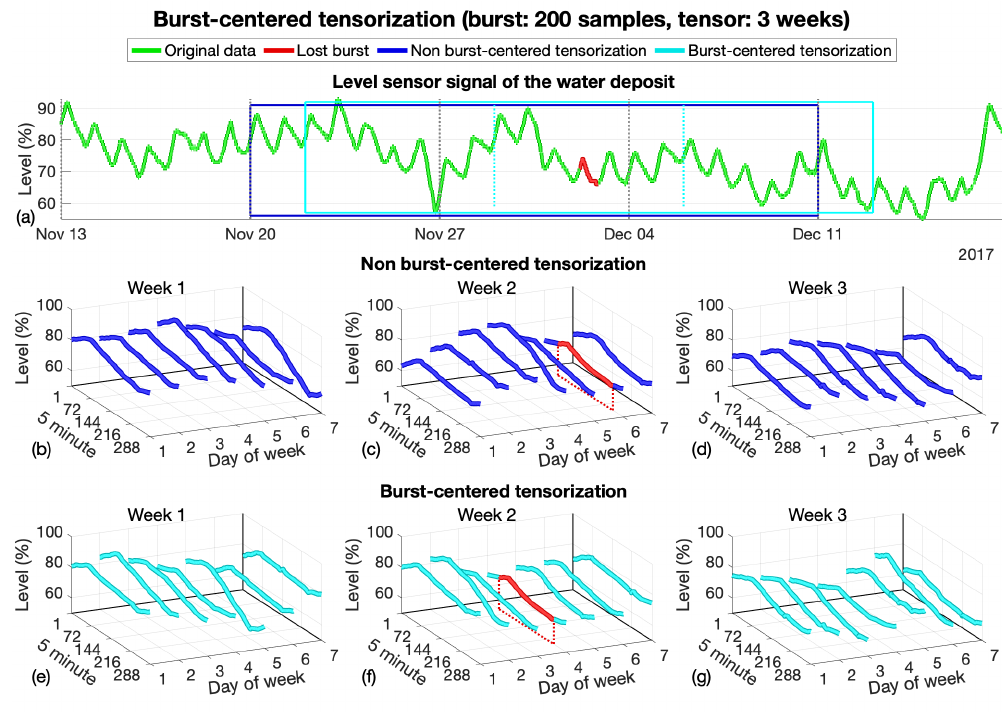
Figure 6. Example of the data tensorization of a 3 week tensor with 200 samples of data burst lost. In figure ( a ) the green line shows the original data and the red line shows the lost burst. The strong blue window shows the data introduced in the non burst-centered tensor and the soft blue one shows the data introduced in burst-centered tensor, which forces the burst to be on the center of the window. Figures ( b – d ) show the three weeks of the non burst-centered tensor and the location of the burst, which is located on the central week but not on the center of this week. The figures ( e – g ) show the 3 weeks of the burst-centered tensor and the new location of the burst in the core of the tensor, which is in the middle of the central